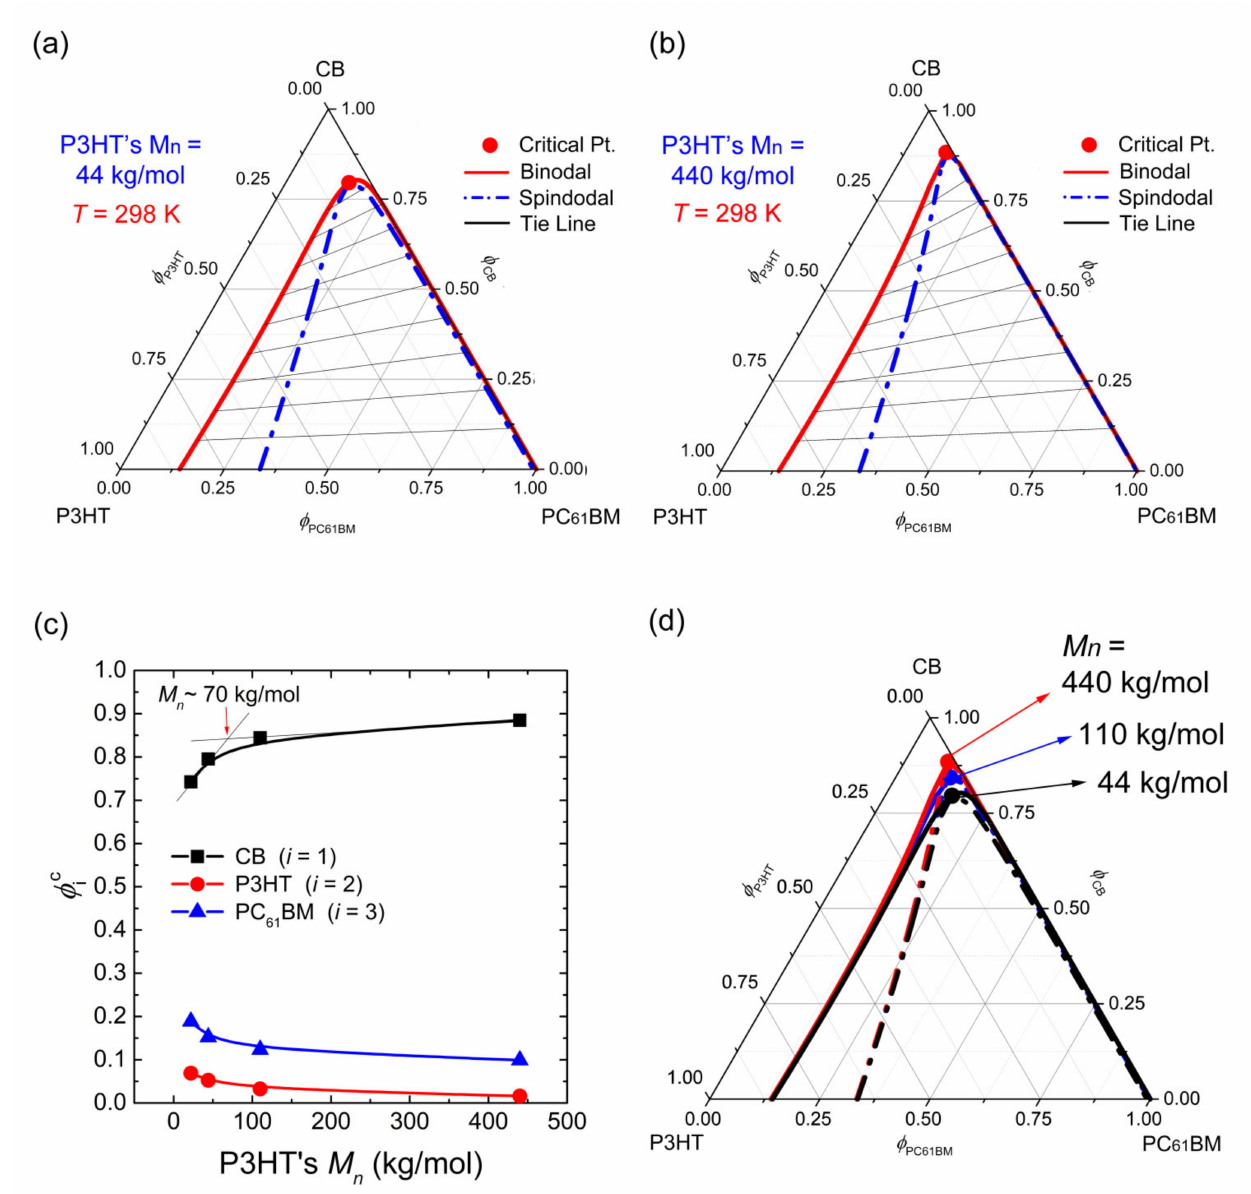
Figure 4. Phase diagrams for the ternary CB/P3HT/PC 61 BM system as a function of the molecular weight of P3HT, when χ 12 = 0.45, χ 13 = 0.90, and χ 23 = 1.50 at constant T = 298 K: ( a ) P3HT’s M n = 44 kg/mol, s = 0.002535, and r = 0.167068, and ( b ) P3HT’s M n = 440 kg/mol, s = 0.000254, and r = 0.167068. ( c ) Critical point ( φ c system as a function of molecular weight. ( d ) Comparison of the three phase diagrams with different Mn. Note that, when P3HT has M n = 110 kg/mol, the physical quantities (s = 0.001014 and r = 0.167068) are used for calculating the ternary phase